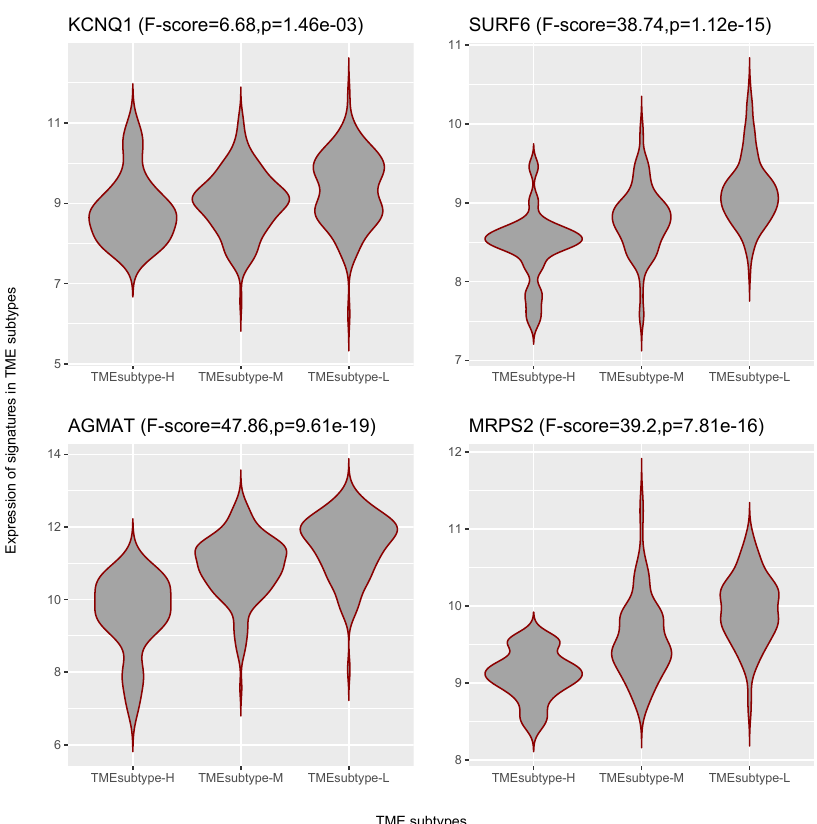
Figure 23. Violin plots showing differential expression of representative EMEC markers in three TME